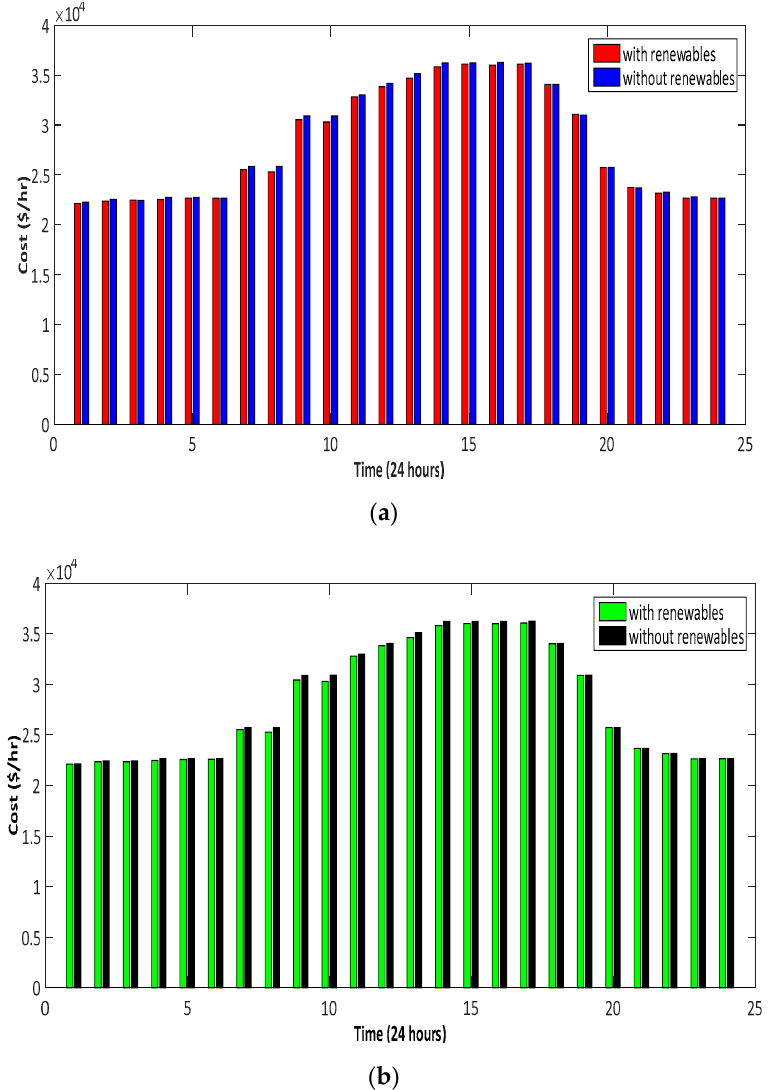
Figure 12. Cost offered by the ( a ) BA and ( b ) dBA without and with considering renewables. Figure 12. Cost o ff ered by the ( a ) BA and ( b ) dBA without and with considering